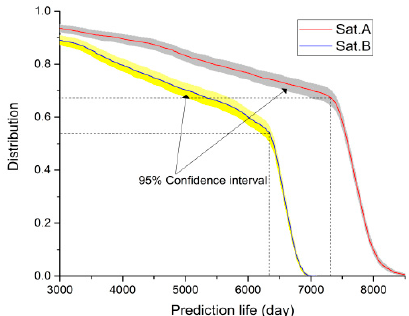
Figure 12. Probability distribution of the predicted life.